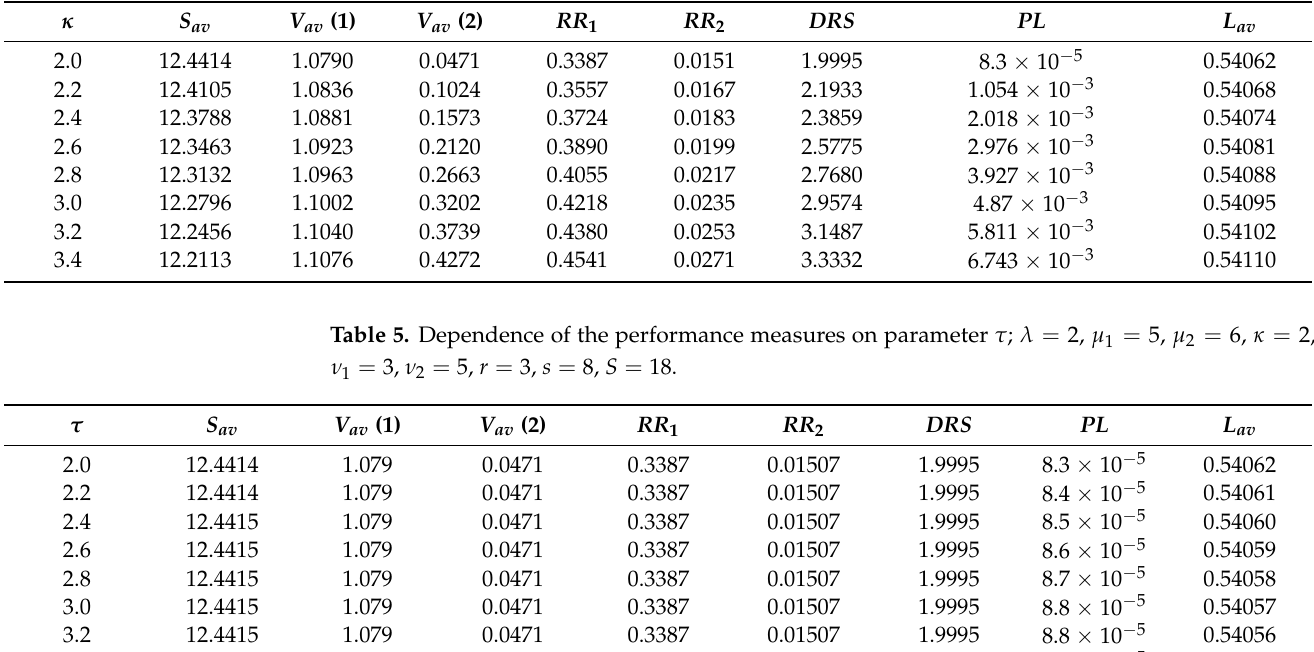
Table 4. Dependence of the performance measures on parameter κ ; λ = 2, µ 1 = 5, µ 2 = 6, τ = 2, ν 1 = 3, ν 2 = 5, r = 3, s = 8, S = 18.